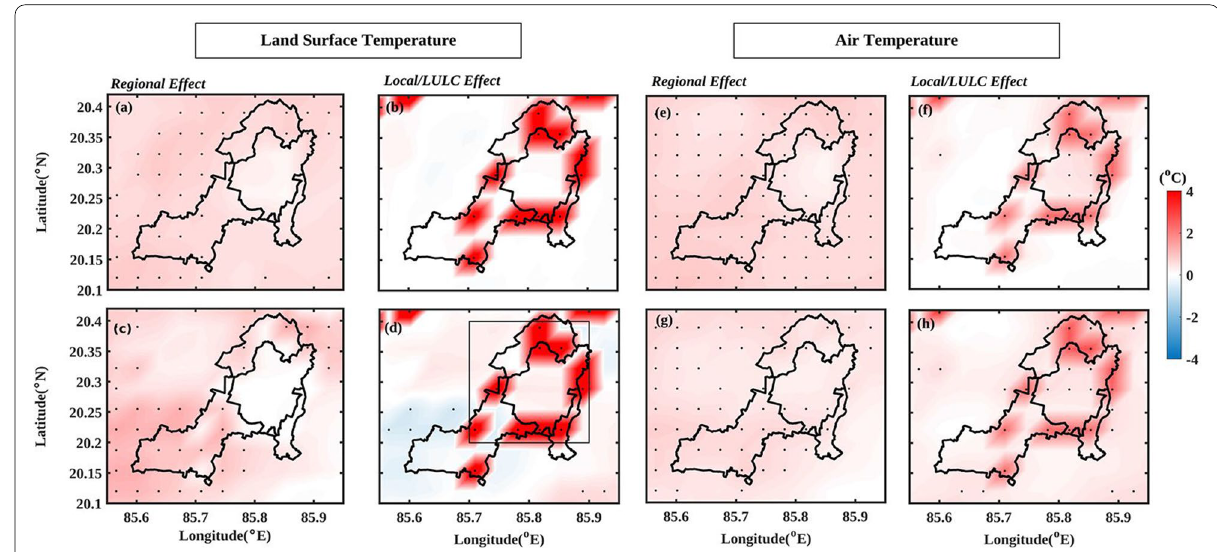
Fig. 5 The LULC and regional effects on temperature. Night-time temperature changes, a Regional effect(EXP1-CNTL2004), b Local/LULC effect(CNTL2015-EXP1), c Regional effect (CNTL2015-EXP2), d Local/LULC effect (EXP2-CNTL2004). e-f , same as ( a-d ) but for air